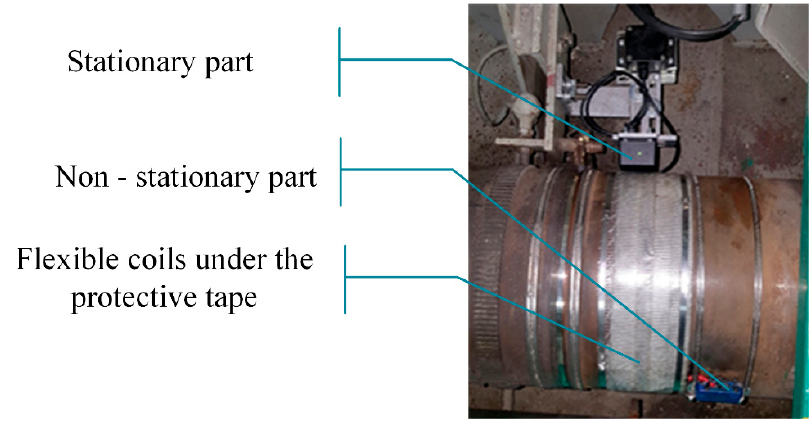
Figure 7. Prototype of the power measurement unit after the assembly on the main propulsion shaft.